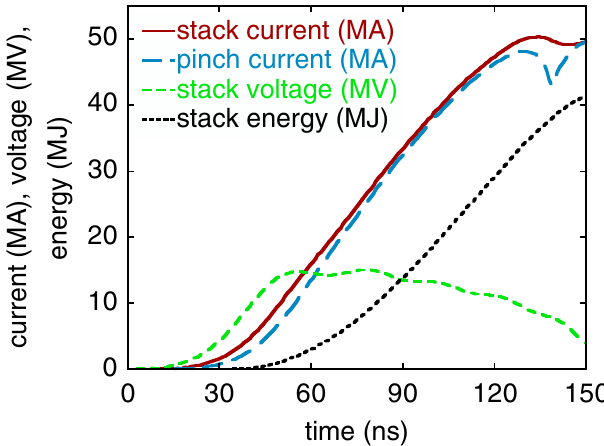
FIG. 2. (Color) The stack current, pinch current, stack voltage, and stack energy for the Marx-based accelerator referred to as option 1 in Table